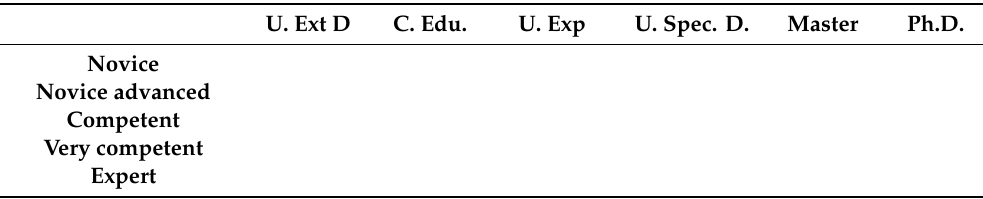
Table A3. Type of training